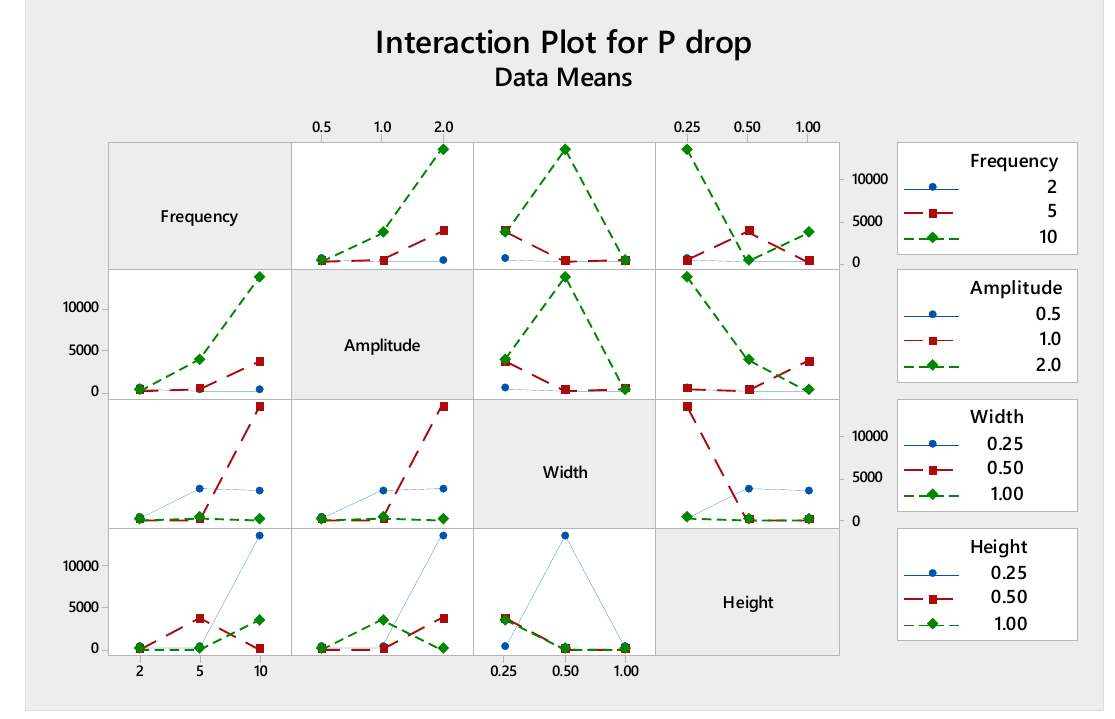
Figure 6. The interactions of various parameters with respect to pumping power.